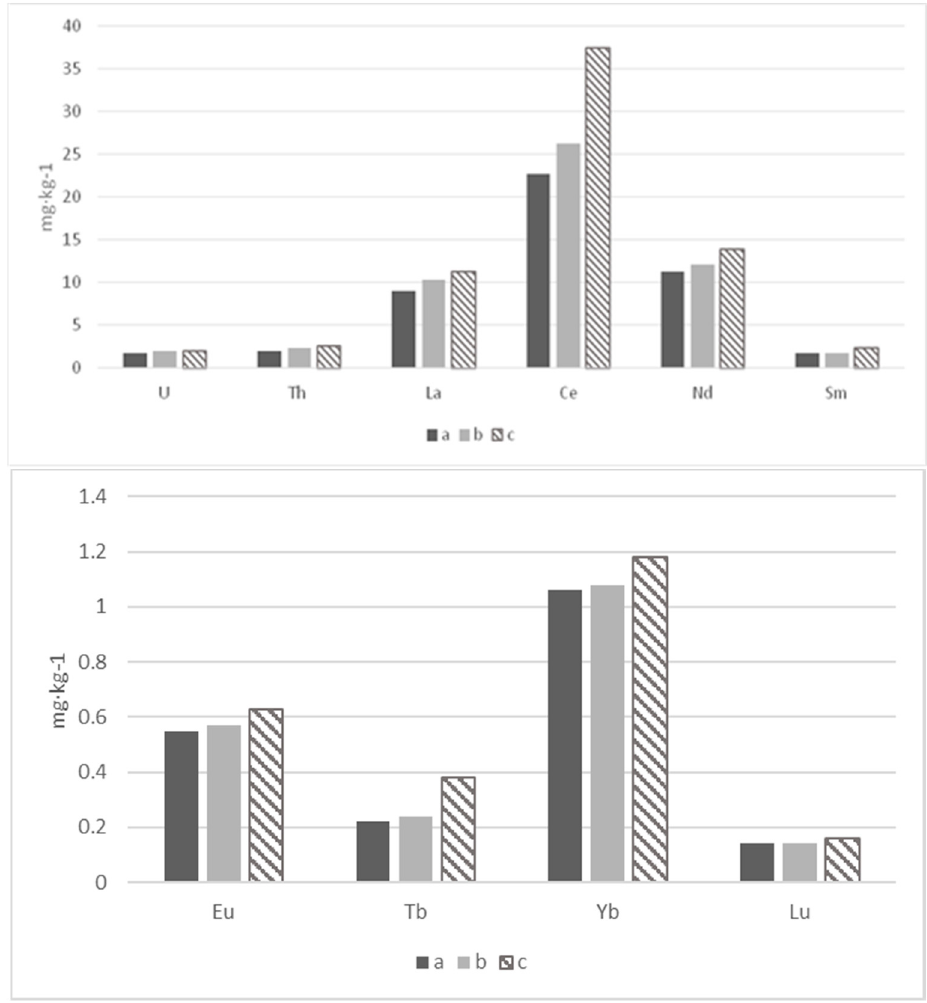
Figure 3. Content of lanthanides, uranium and thorium in soils: ( a ) paleosols under barrows; ( b ) paleosols of settlement; ( c ) recent background soils.